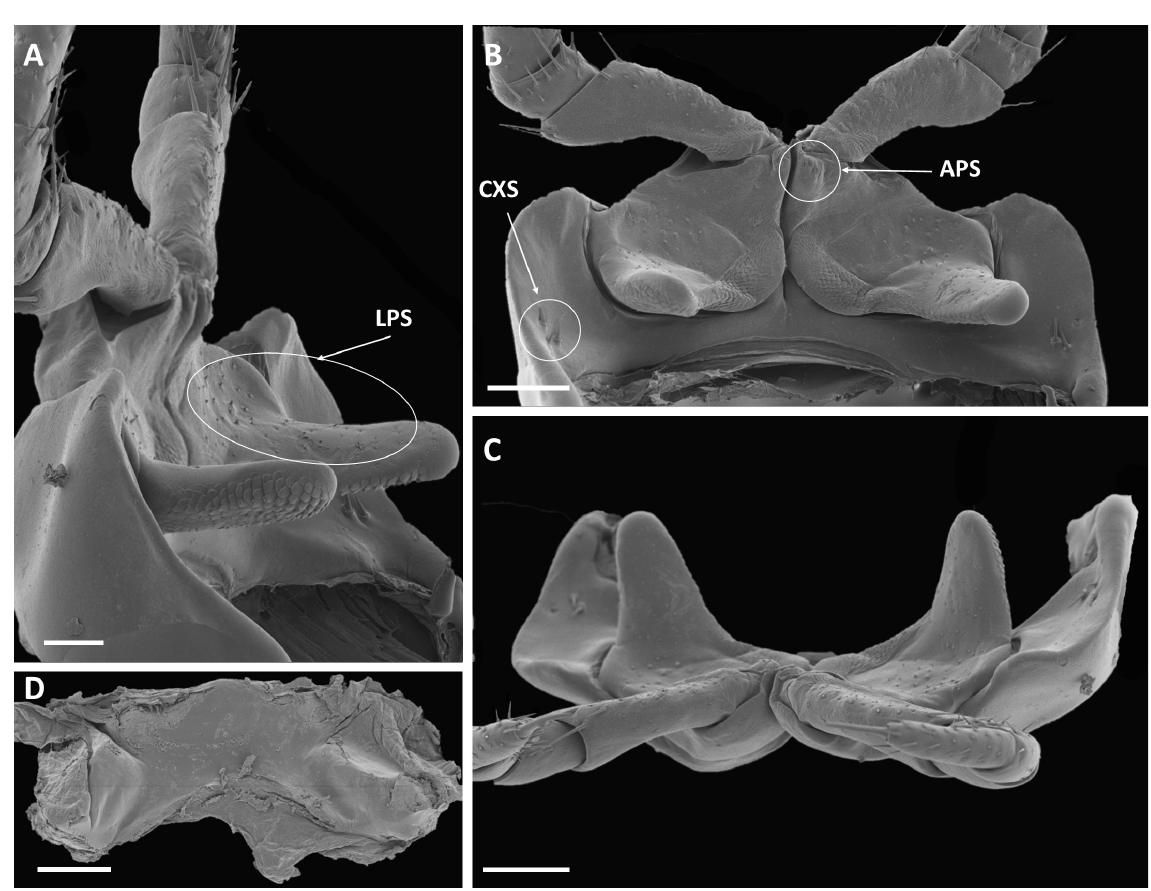
Fig. 14. Calyptomastix ingemanni sp. nov., holotype, ♂ (NHMD 621715). A–C . First pair of legs. A. Sublateral view. B. Anterior view. C. Ventral view. D . Sternum 9. Abbreviations: APS = mesapical prefemoral setae; CXS = coxosternal setae; LPS = lateral prefemoral setae. Scale bars: A = 0.1 mm; B–D = 0.2